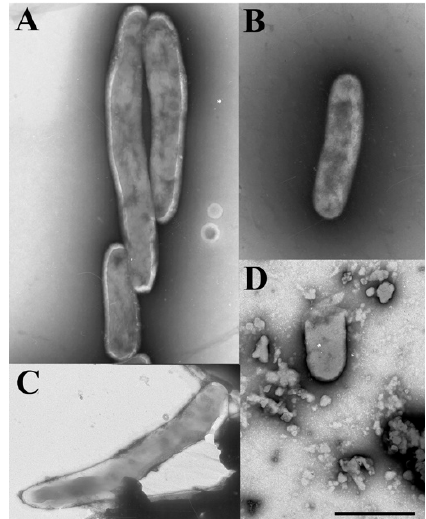
Figure 4. Transmission electron microscopy of M. tuberculosis H37Rv bacterial cells. Control bacterial cells were grown for 4 days in enriched Dubois medium ( A ) or in enriched Dubois medium containing DMSO/Twin-80/H 2 O solution without compound 3 ( B ). Bacterial cells after treatment with compound 3 (50 μ g/mL) for 4 days ( C and D ). Scale bar = 1 μ m.